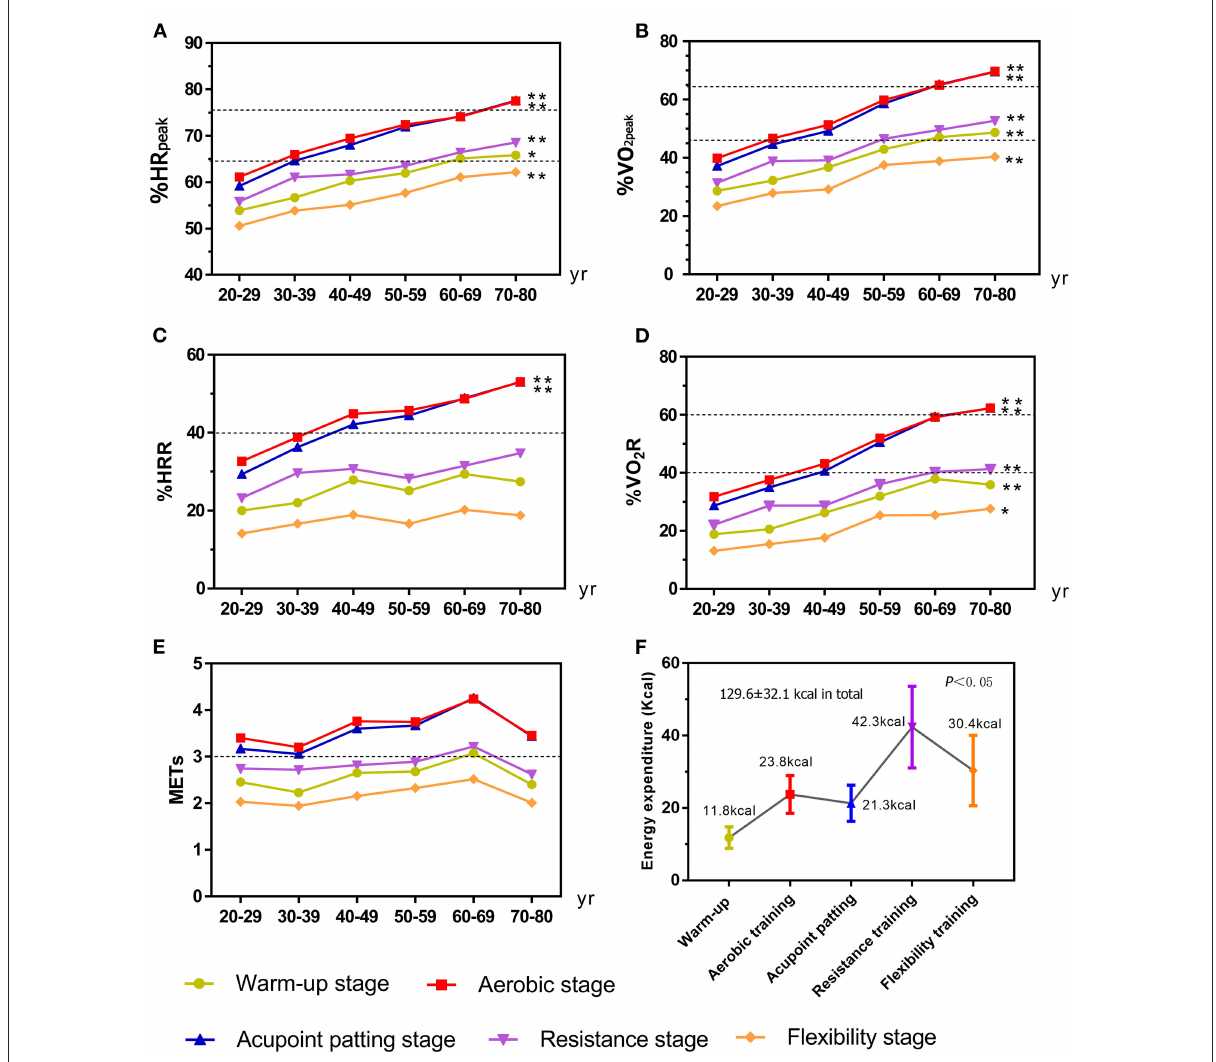
FIGURE3 The exercise intensity and energy expenditure of the X-CircuiT program between different age groups. (A) Shows the peak heart rate percentage (%HR peak ); (B) Shows the peak oxygen intake percentage (%VO 2peak ); (C) Shows the heart rate reserve percentage (%HRR); (D) Shows the oxygen uptake reserve percentage (%VO 2 R); (E) Shows metabolic equivalent (METs); and (F) Shows the energy expenditure of each stage and the whole set of the X-CircuiT. The dotted lines are the medium intensity exercise (lower line) or high intensity (higher line) exercise boundary. * Indicates the difference between groups p < 0.05; and ** indicates the difference between groups p < 0.01